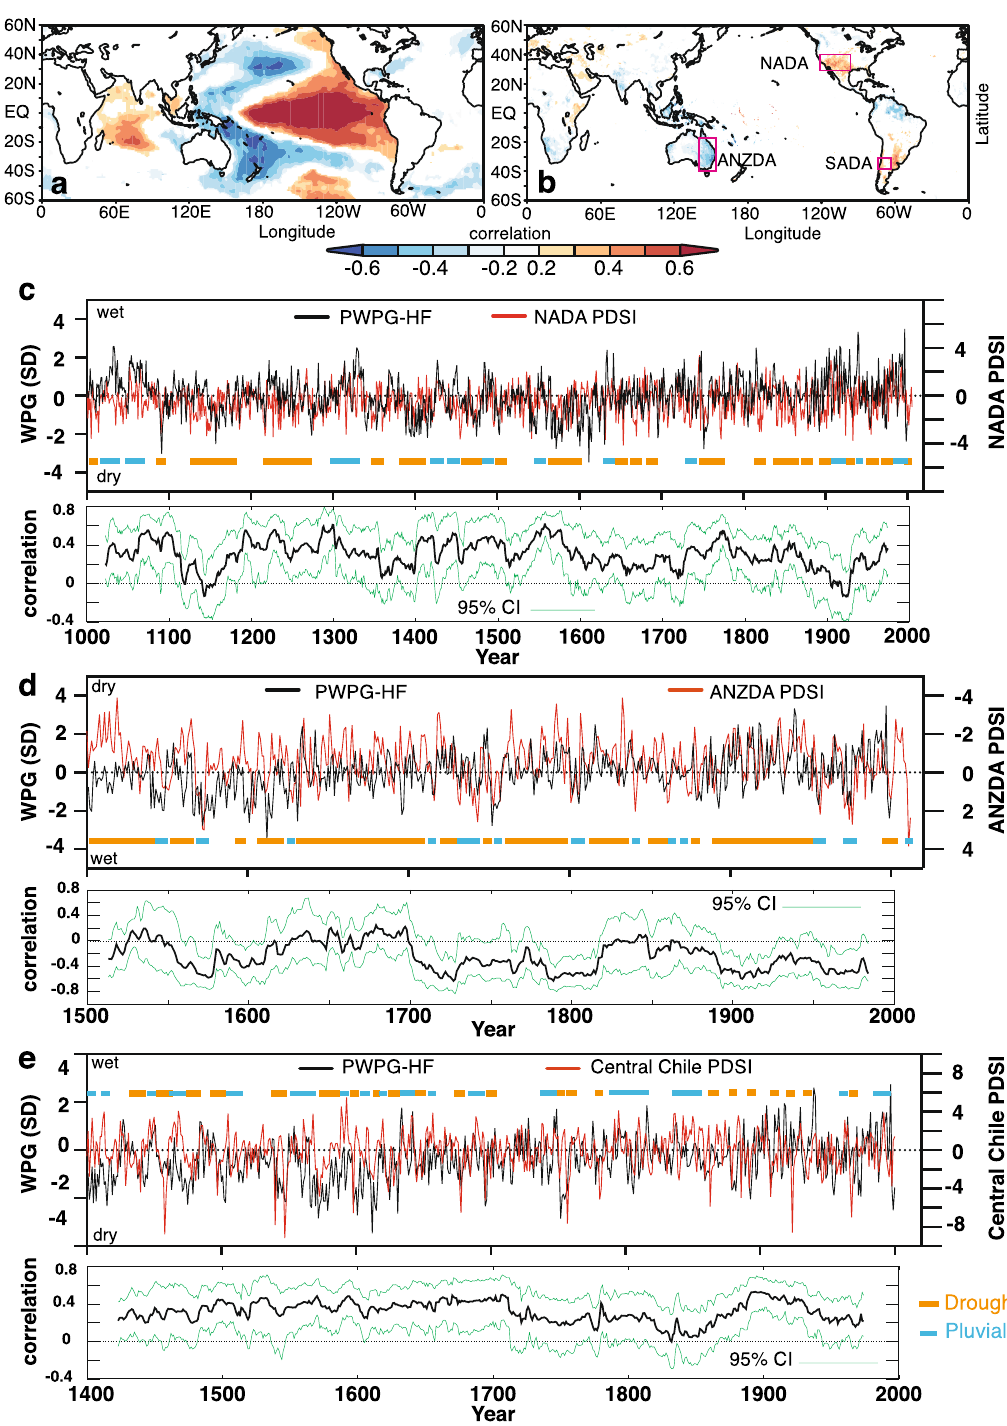
Figure 7. Comparison between the West Pacific Gradient (WPG) reconstruction from PHYDA34 and palaeohydrological data. Time series were normalised relative to 1961–1990 (SD = standard deviation). ( a ) Spatial correlations between the PHYDA-West Pacific Gradient (PWPG-HF) reconstruction (after 24 ) with instrumental 58 HadISST and ( b ) with GPCC rainfall 59 . Only correlation > 95% significance coloured. Spatial correlations in ( a ) and ( b ) computed in KNMI climate explorer 61 (https:// clime xp. knmi. nl/). PHYDA-WPG (PWPG-HF) compared to ( c ) North American drought atlas (30–40°N, 125–105°W 62 ) and 51-year running correlation, ( d ) Australia-Nea Zealand drought atlas PDSI (18–29°S, 140–155°E; ANZDA 38 ) and 51-year running correlation, and ( e ) Central Chile PDSI from the South America Drought Atlas (31–37°S, 70–72°W; SADA 42 ) and 51-year running correlation. Dry (orange) and wet (blue) conditions are indicated. Correlation coefficients (year to year) are also indicated over full period of overlap for detrended